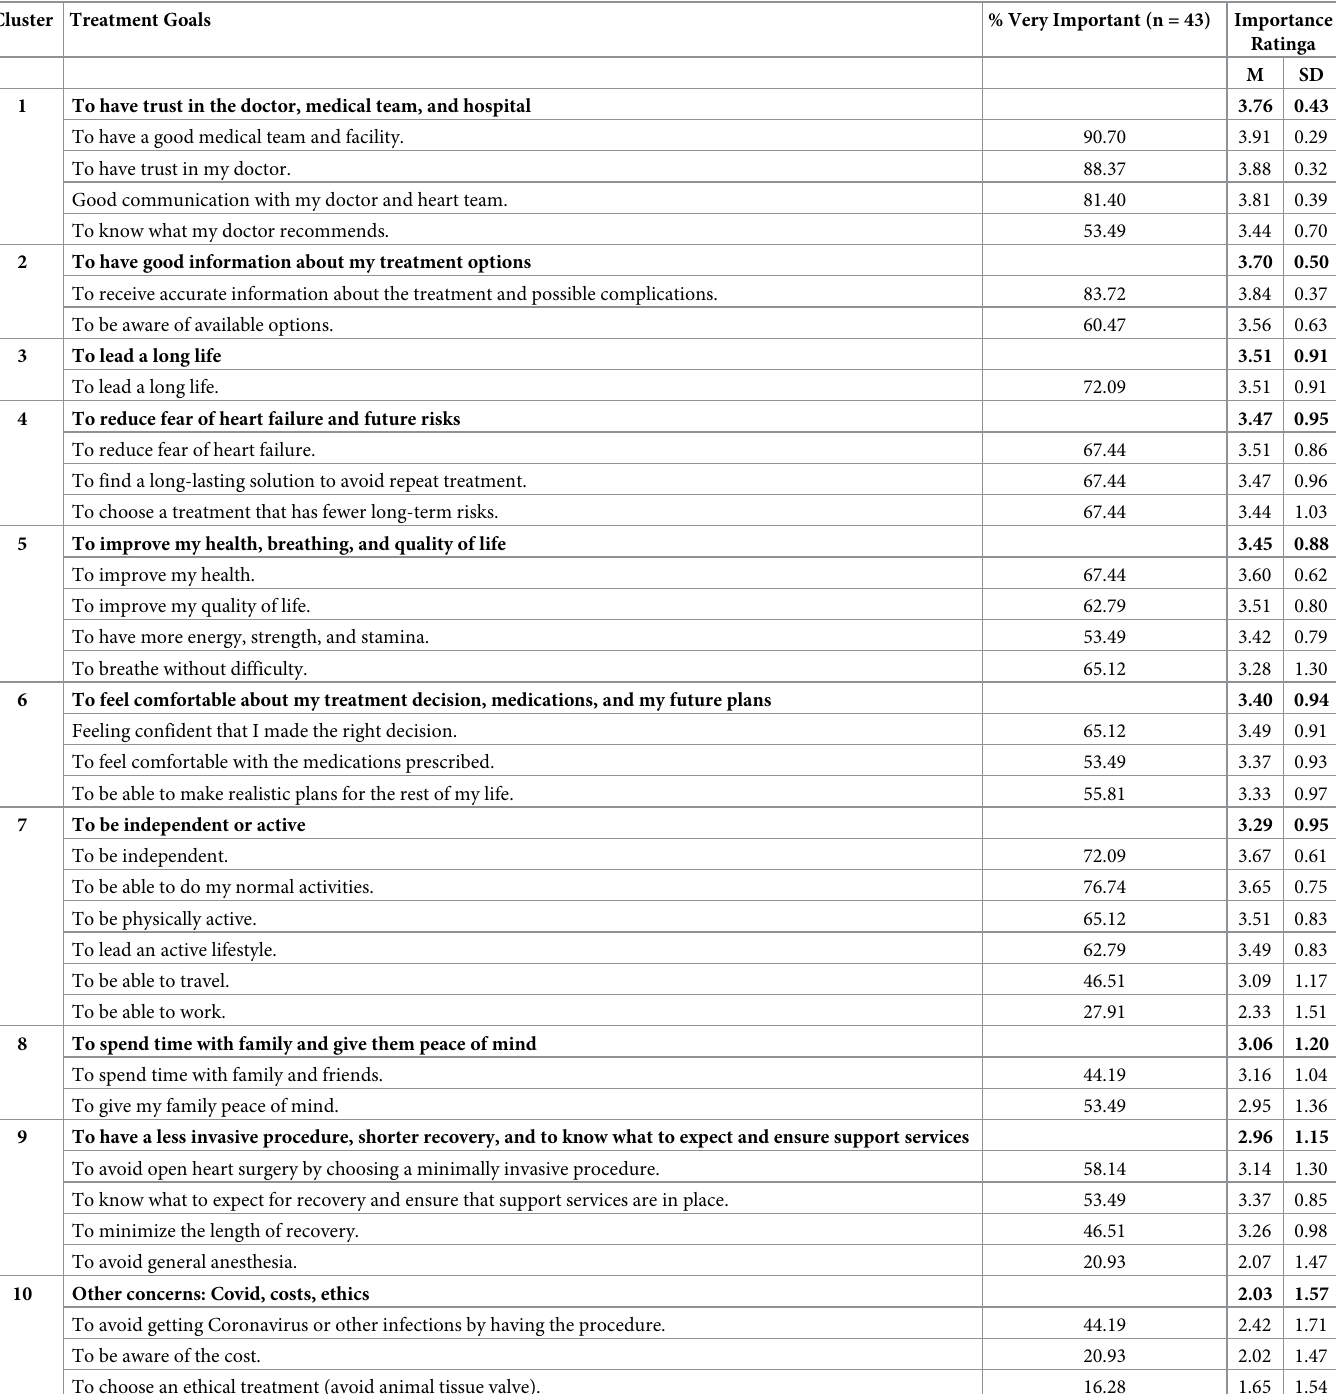
Table 2. Patient treatment goals, prioritized clusters with patient ratings. Cluster Treatment